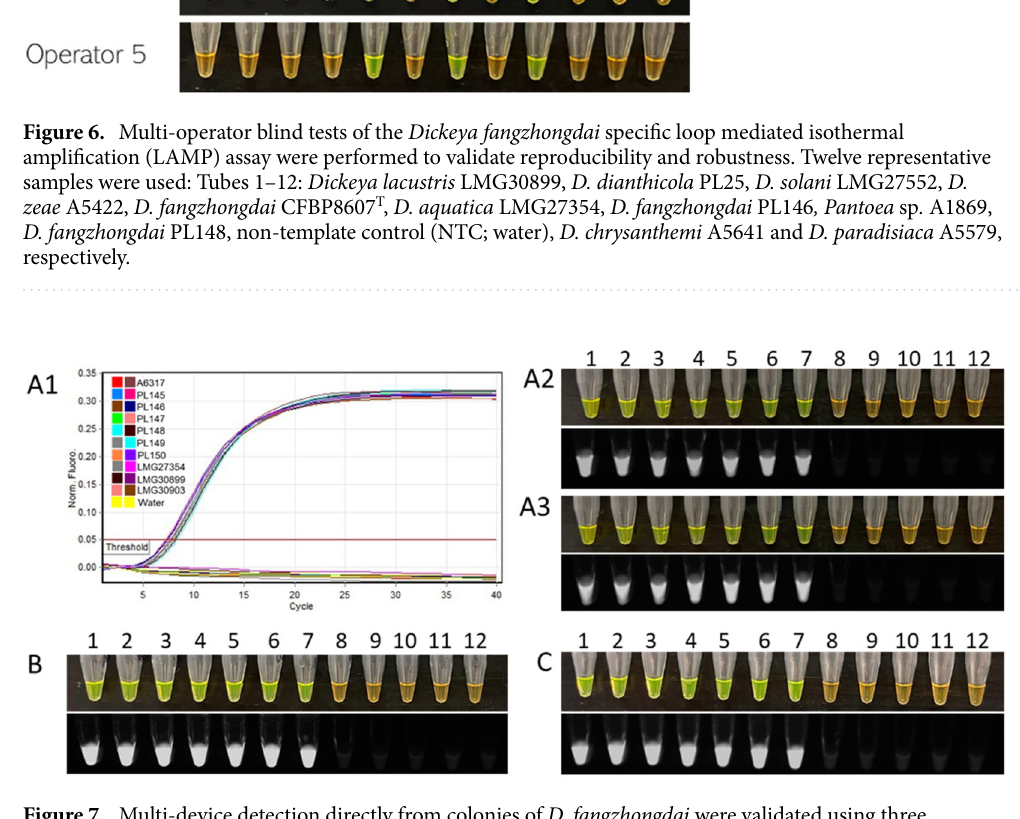
Figure 7. Multi-device detection directly from colonies of D. fangzhongdai were validated using three different incubation platforms. Eleven representative samples were tested. Tubes 1–11: D. fangzhongdai strains CFBP8607 T , PL145, PL146, PL147, PL148, PL149, PL150, D. aquatica LMG 27354, D. lacustris LMG30899, D. undicola LMG30903, D. oryzae A5410 and non-template negative control (NTC; water), respectively. Three detection methods were used: sigmoidal curves, SYBR Green I dye detected visually, and fluorescence detection under UV light. ( A1 – A3 ) Rotor-Gene amplification reaction performed by two independent groups with positive amplification observed by sigmoidal curve and further visualized by adding SYBR Green Dye—bright green color indicative of positive amplification; ( B ) LAMP amplification using an endpoint thermal cycler and visualized by adding SYBR Green Dye; ( C ) LAMP amplification using a dry bath (hot plate) and visualized by adding SYBR Green